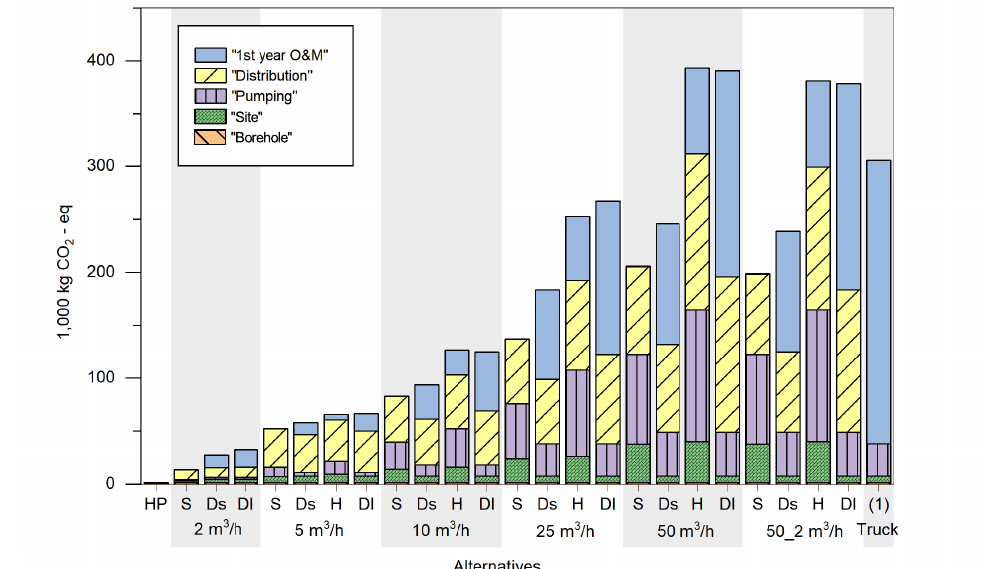
Figure 8. Carbon footprint (kg CO 2 -eq) for all the assessed alternatives (Supplementary Material A.22).